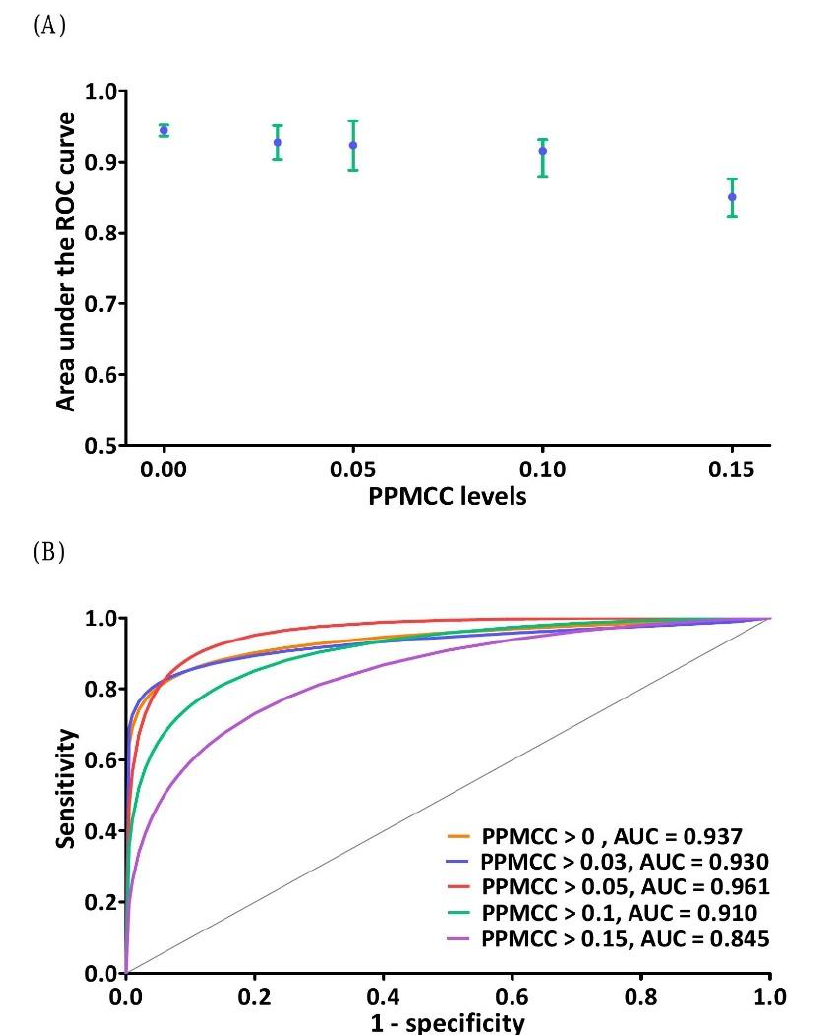
Figure 2. ( A ) Optimization of feature extraction. The feature extraction process was optimized by testing different PPMCC levels to select different medical data as the variables of the scoring function. The tested PPMCC levels were higher than 0.00, 0.03, 0.05, 0.1 and 0.15 corresponding to areas under the ROC curves (AUCs) of 94.40 ± 0.49%, 92.72 ± 2.40%, 92.32 ± 3.45%, 91.52 ± 1.56% and 85.02 ± 2.57%, respectively. The error indicates one standard deviation, which is the result of five individual runs of each scoring function. ( B ) The maximum AUCs of the five individual runs of each scoring function.PPMCC: The Pearson product-moment correlation coefficient; ROC: receiver operating